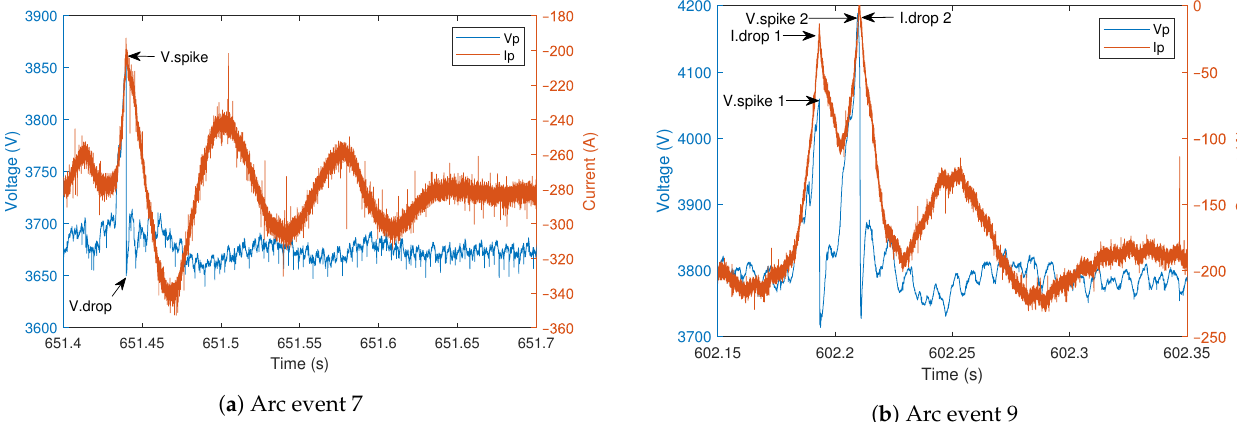
Figure 2. Time domain representation of pantograph voltage V p and pantograph current I p during arc event 7 and 9 occurred in a regenerative braking